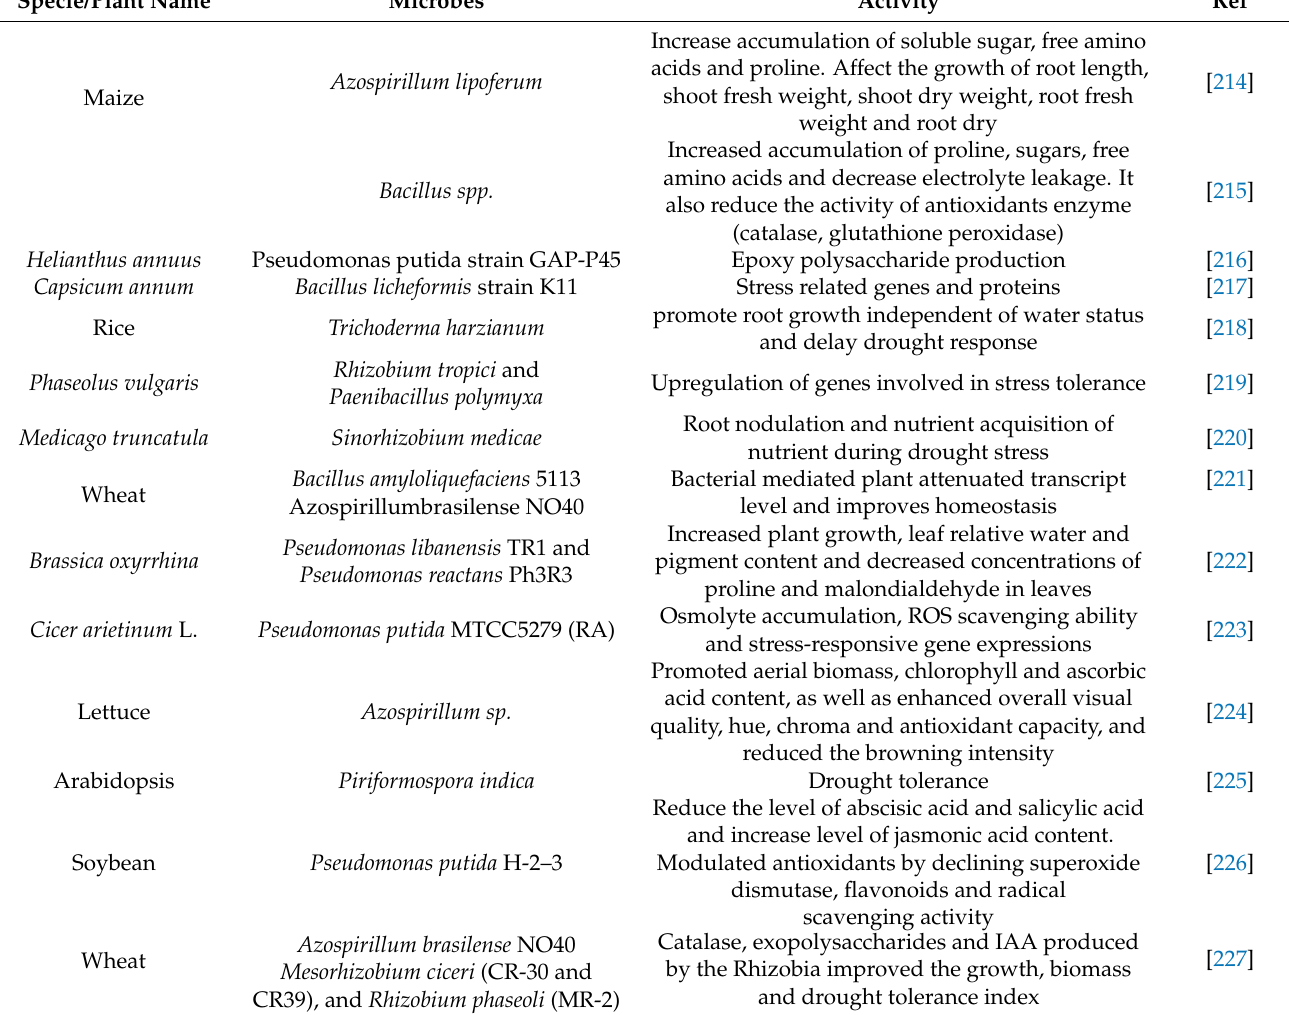
Table 7. Effect of microbes on plant adaptive mechanism for mitigation of drought